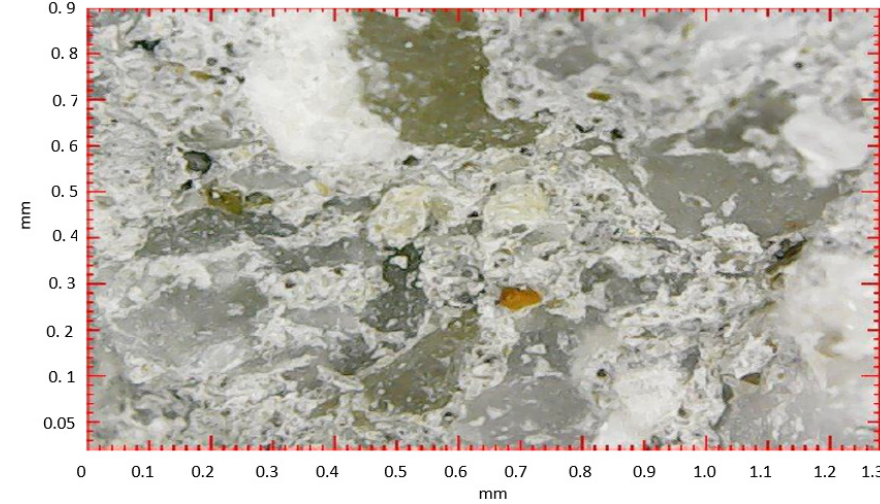
Figure 5. Structures of the air void system of NC.